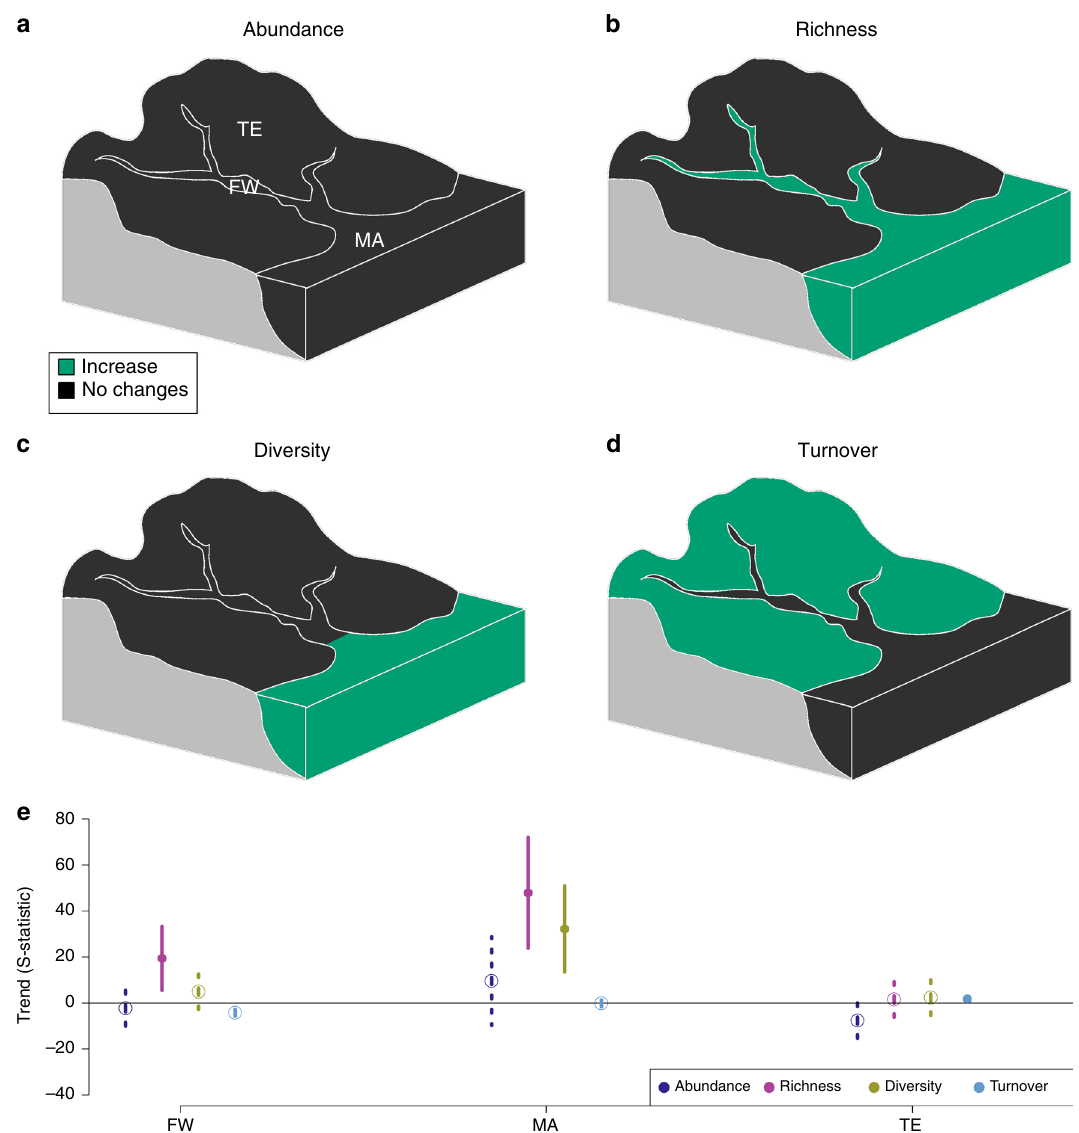
Fig. 3 Biodiversity trends in the three realms. The results of meta-analysis mixed models are shown for the four studied biodiversity metrics: abundance ( a ), richness ( b ), diversity ( c ) and turnover ( d ). Green: signi fi cant increasing trends ( p ≤ 0.05); black: no signi fi cant trends ( p > 0.05). e Values of S- statistics (model estimated mean, error bar: + / − C.I.). Dark blue: abundance, pink: richness, yellow: diversity, light blue: turnover. Solid line and dot: p ≤ 0.05; dashed line and open circle: p > 0.05. FW freshwater ( n = 51 time series); MA marine and transitional zones ( n = 18 time series); TE terrestrial ( n = 92 time series). Source data are provided as a Source Data fi